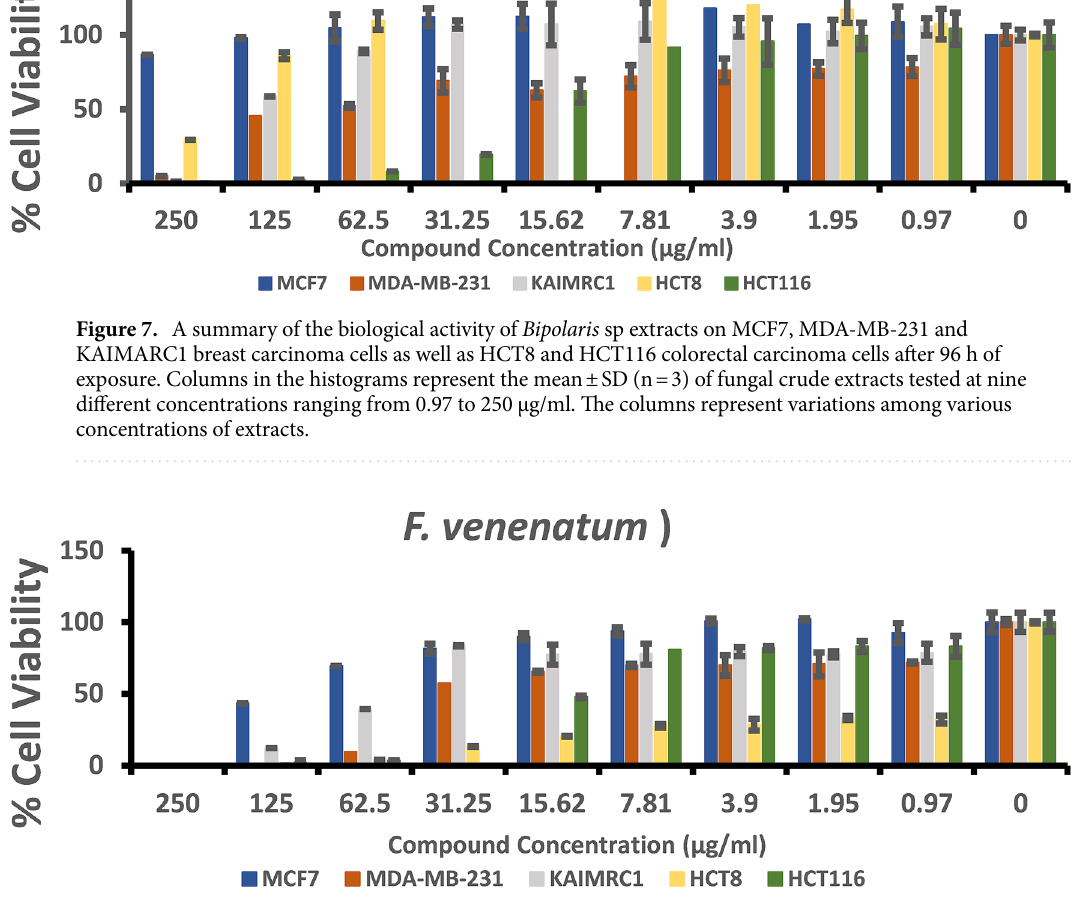
Figure 8. A summary of the biological activity of Fusarium venenatum extracts on MCF7, MDA-MB-231 and KAIMARC1 breast carcinoma cells as well as HCT8 and HCT116 colorectal carcinoma cells after 96 h of exposure. Columns in the histograms represent the mean ± SD (n = 3) of fungal crude extracts tested at nine different concentrations ranging from 0.97 to 250 μg/ml. The columns represent variations among various concentrations of extracts.